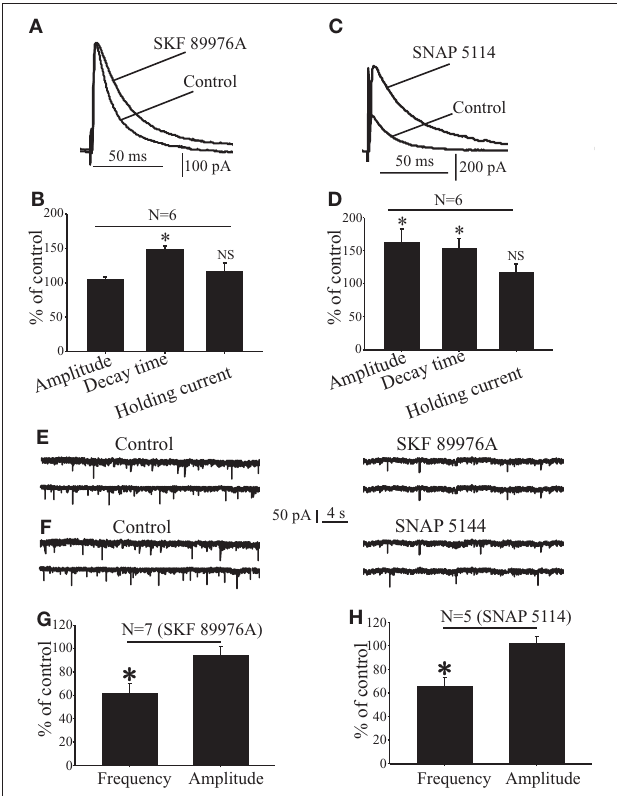
FiGurE 5 | Effects of GAT-1 and GAT-3 blockade on GABAergic and glutamatergic synaptic transmission in the rat GP. (A) Application of SKF 89976A increases the decay time, but not the amplitude of IPSCs evoked in GP neurons after striatal stimulation. (B) Bar graph showing that SKF 89976A increases the decay time, but has no effect on the amplitude and base line holding currents of eIPSCs expressed as percent of control ± SEM (* P < 0.005). (C) Application of SNAP 5114 increases the amplitude and decay time of IPSCs evoked in GP neuron by striatal stimulation. (D) Bar graph summarizing the effects of SNAP 5114 on eIPSCs amplitude, decay time, and holding current expressed as percent of control ± SEM (* P < 0.005). (E,F) . Sample traces showing mEPSCs recorded in control condition and during SKF 89976A or SNAP 5114 application. (G,H) The summary bar graphs show that SKF 89976A or SNAP 5114 significantly reduce the frequency, but not amplitude of mEPSCs. * P < 0.01. For more details see Jin et al. (2009, 2011).